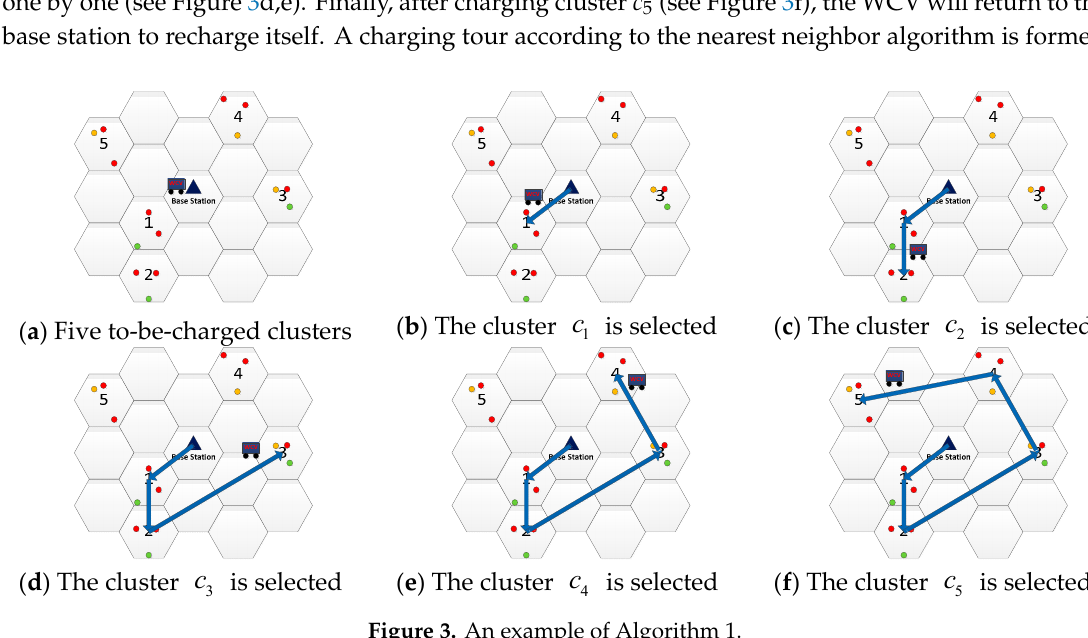
Figure 3. An example of Algorithm 1.